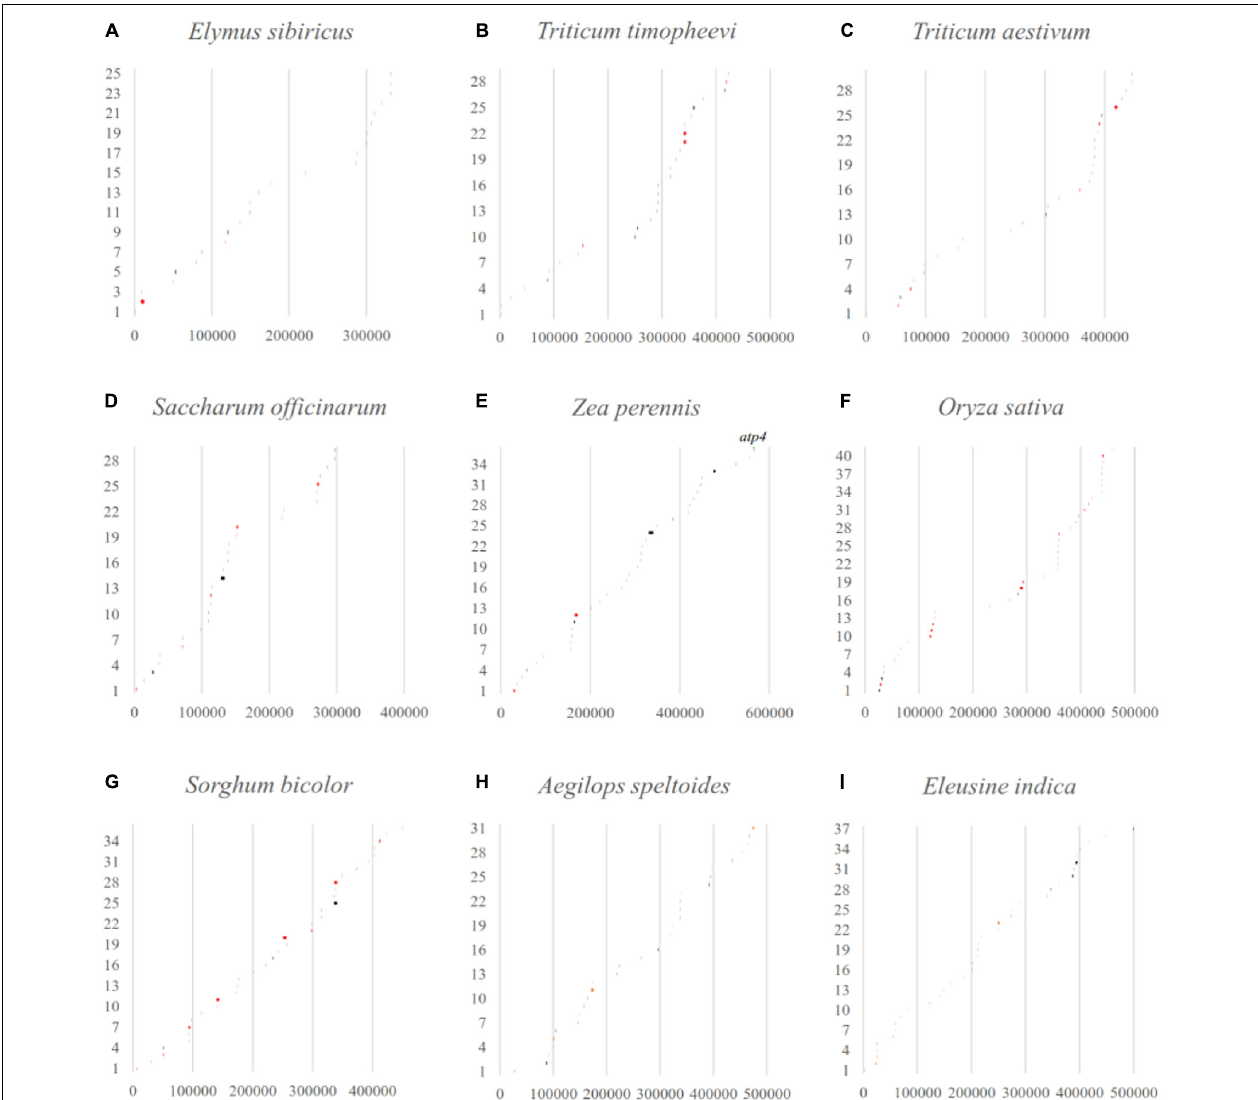
FIGURE 6 | The gene transfer between mitochondrial and chloroplast genomes in Gramineae was verified by blast software. The x -axis and y -axis represent the mitogenome location (bp) and the order of the transferred sequences, respectively. The black and red lines indicate perfect match regions located in intergenic or partial genic regions. The matched whole genic region was labeled with gene